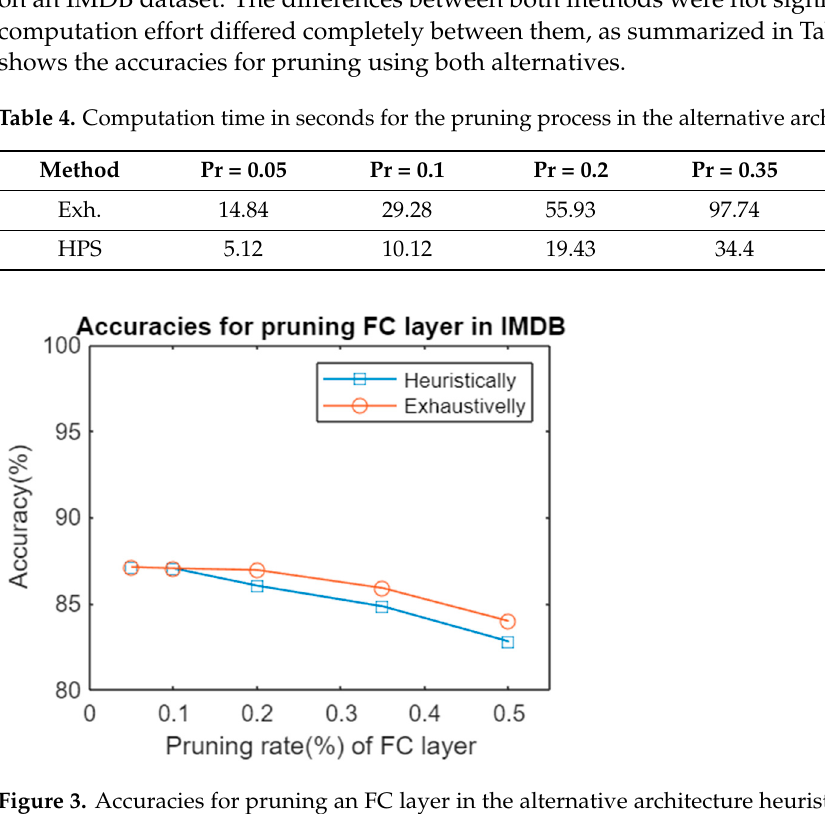
Figure 2. Accuracies for pruning an FC layer in Lenet5 HPS vs. pruning exhaustively. Table 3. Computation time in seconds for the pruning process in Lenet5 architecture.